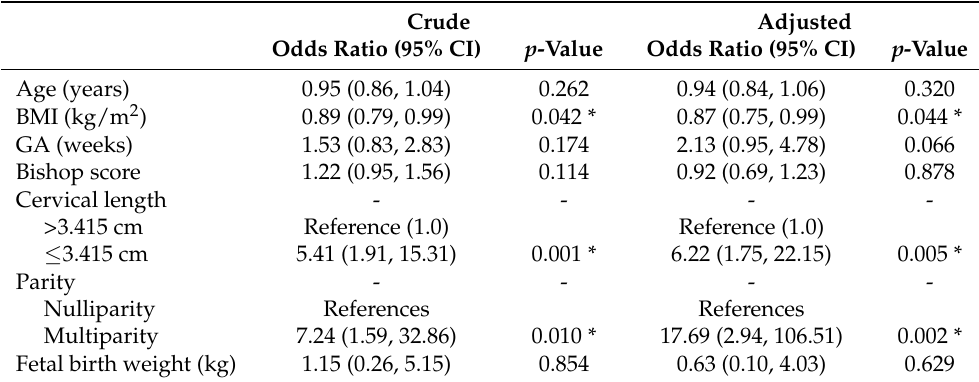
Table 2. Factors associated with successful induction (n = 138).